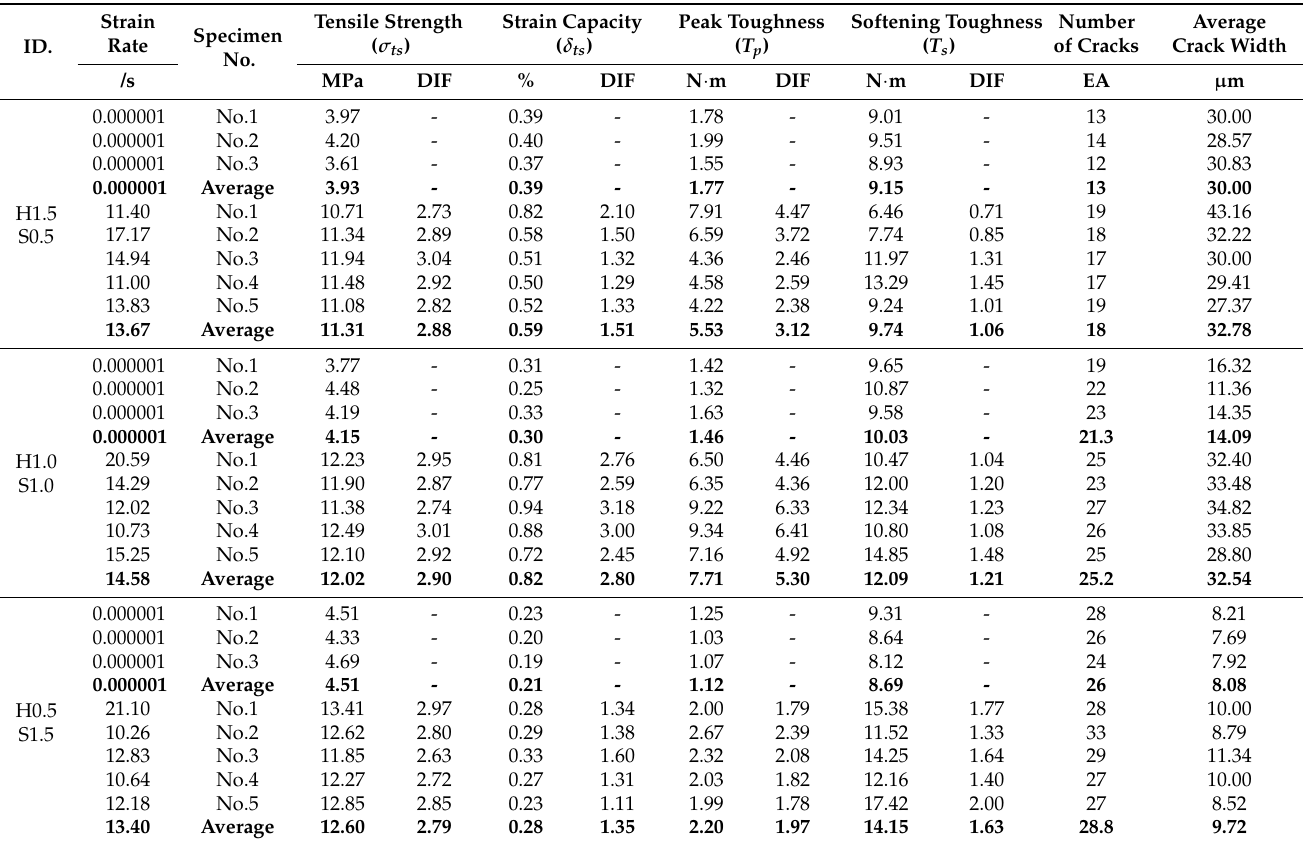
Table 6. Tensile properties of